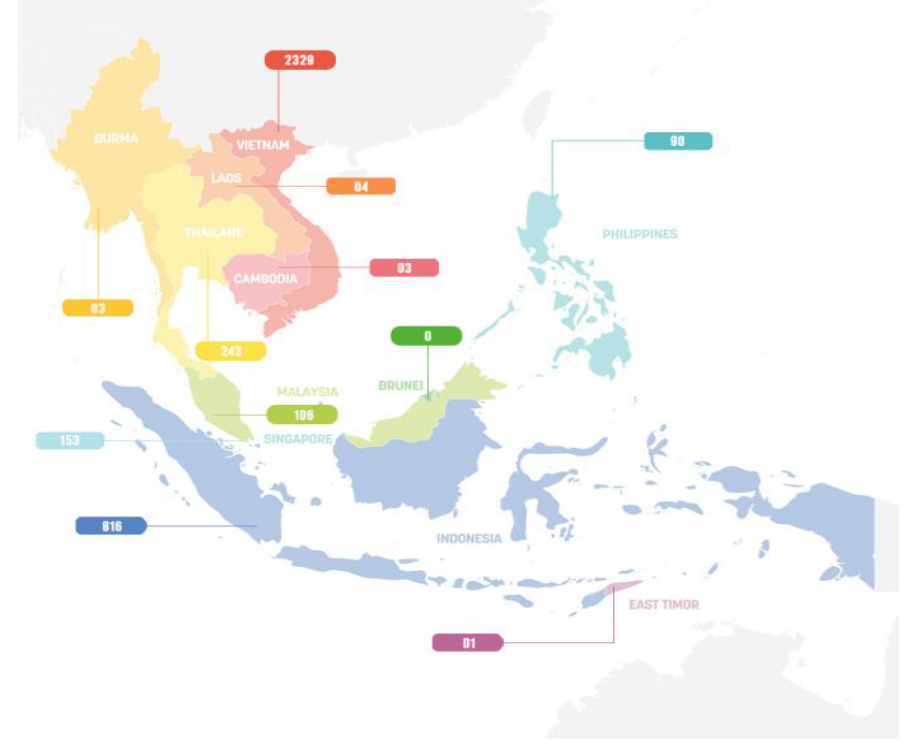
Figure 3. The number of users of codeforces.com in Southeast Asian countries.